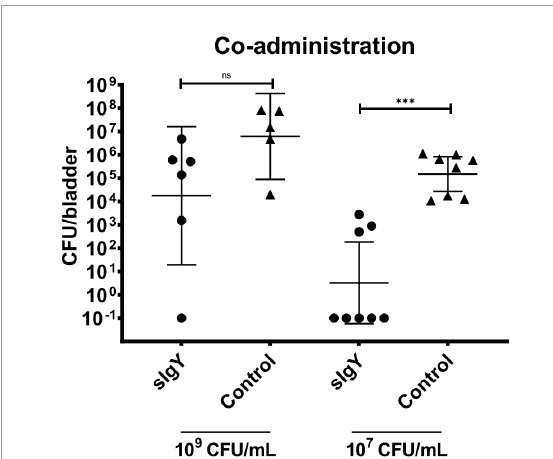
FIGURE3 Co-administration of IgY during infection lowers bladder bacteriology in vivo . A bacterial overnight culture of PAO1 was adjusted to either 2 × 10 9 or 2 × 10 7 CFU/mL in saline. IgY was diluted to reach 40% in saline. Bacteria and IgY or saline (control group) were then mixed to equal parts immediately prior to experiment start. Thirty-two 10-week-old female Balb/c mice were randomized into the four groups, anesthetized, intravesically infected with 50 µ L of the bacteria mixed with IgY or saline and observed for 30 min after infection to exclude mice that were voiding during this period. Twenty hours after infection, all mice were euthanized. Blood, kidneys, and bladders were harvested. The organs were homogenized and quantitative bacteriology was evaluated the next day. Displayed are the CFU (geometric mean with 95% confidence interval) detected in the bladders of all not excluded mice. Statistically significant differences were evaluated by Mann–Whitney tests ( ∗∗∗ p ≤ 0.001). ns, non-significant.